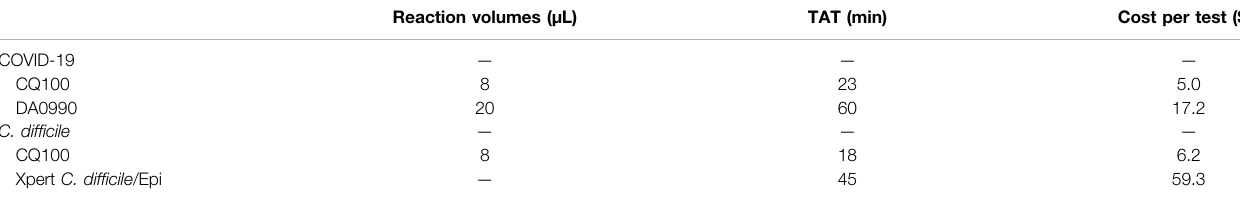
TABLE 3 | Comparison the reaction volumes, TAT and cost per test with other two